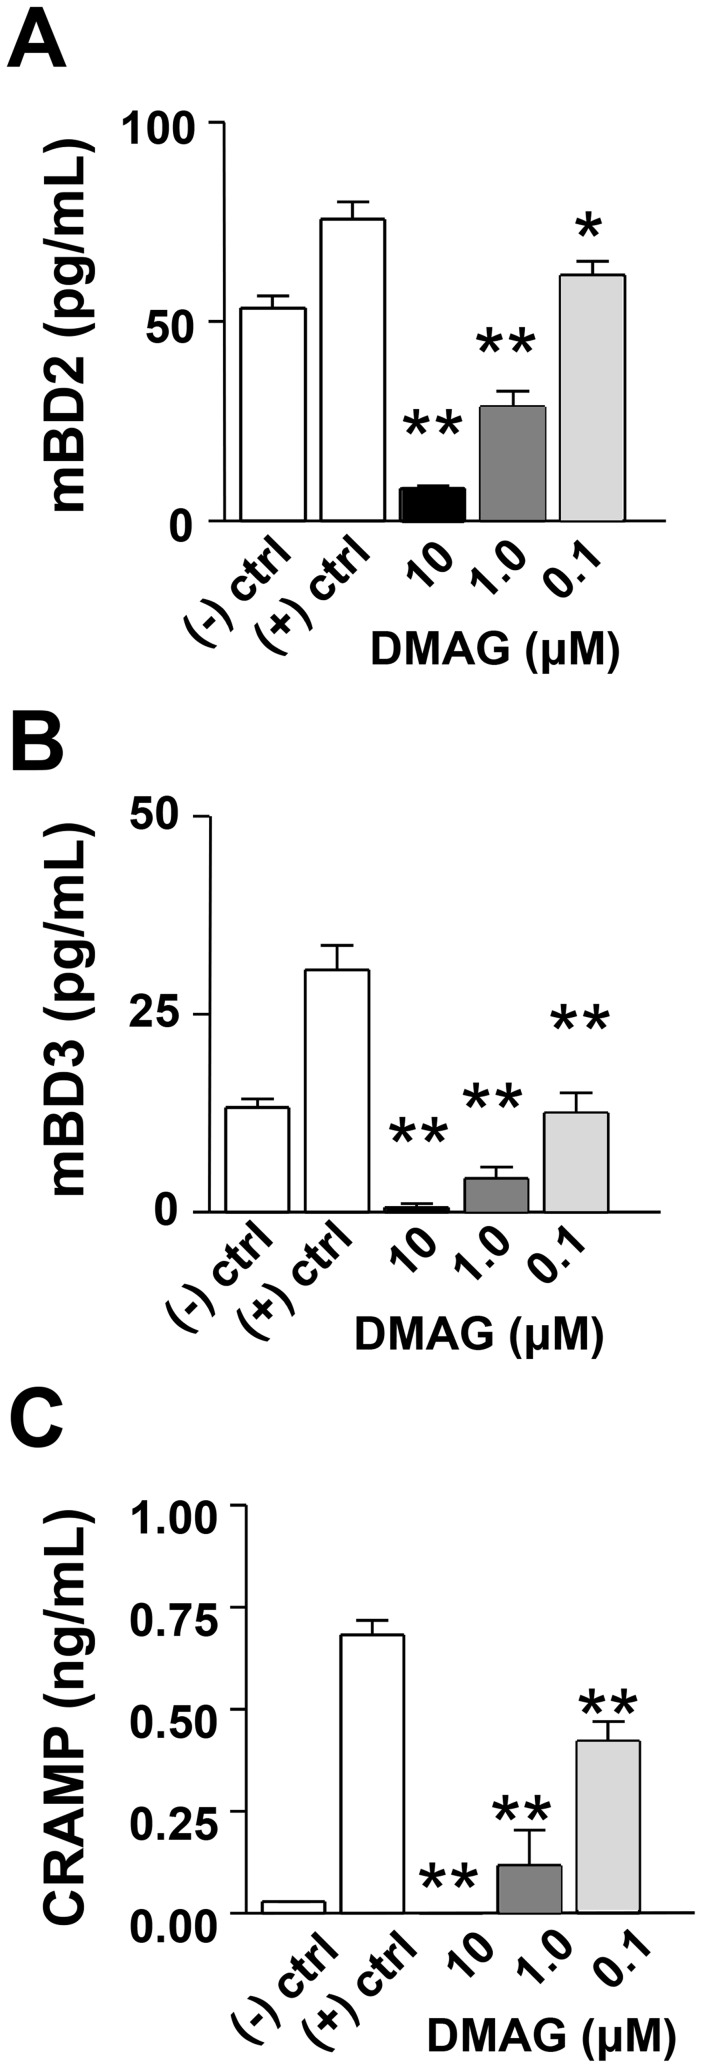
In vitro expression of antimicrobial peptides after HIF-1α inhibition.PMN were stimulated with P. aeruginosa +/− DMAG treatment (10, 1.0, 0.1 µM) for 18 hours, and antimicrobial protein levels from supernatants were determined by ELISA. mBD2 (A), mBD3 (B) and CRAMP (C) were significantly reduced in a dose-dependent response to DMAG treatment when compared to positive controls (bacteria only, no DMAG). *P<0.05, ** P<0.01.